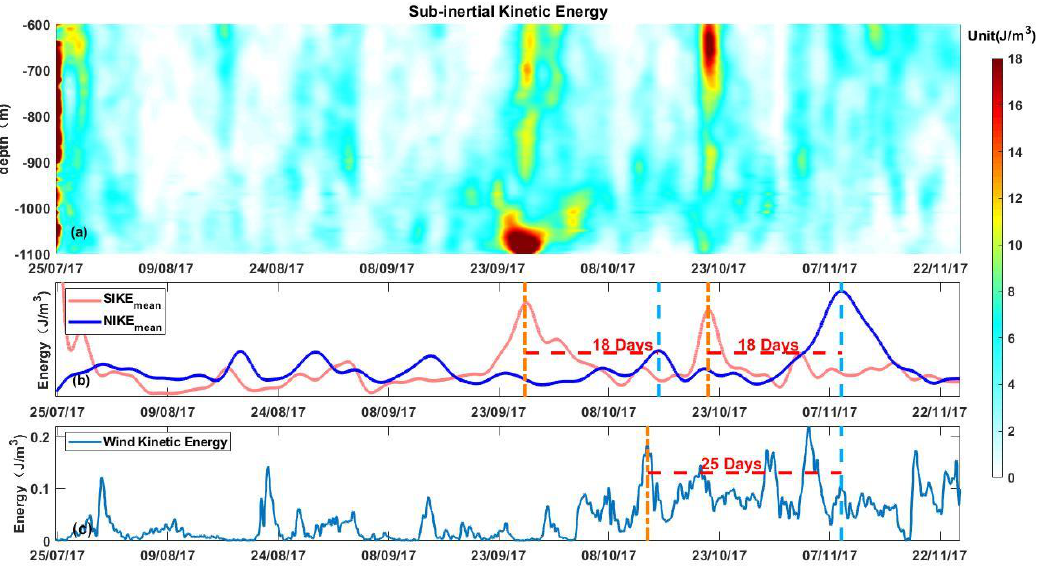
Figure 8. ( a ) Depth–time map of subinertial kinetic energy. Color bar units are J m −3 . ( b ) Depth averages of subinertial kinetic energy and NIKE. The light blue dashed line represents the time of maximum ND and NE NIKE. The orange dotted line represents the time of maximum subinertial kinetic energy. The time difference between the maximum NIKE and maximum subinertial kinetic energy is also marked on the graph. ( c ) Surface wind kinetic energy. The light blue broken line represents the time of maximum NE NIKE. The orange dotted line represents the time of maximum wind kinetic energy. The time difference between the maximum NIKE and wind kinetic energy is also marked on the graph.